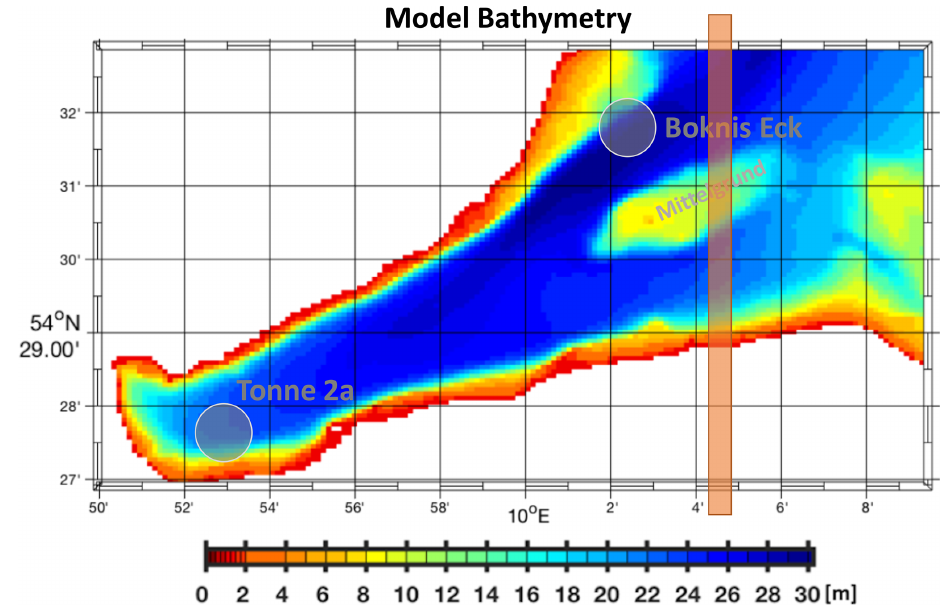
Figure 2. Model bathymetry. The horizontal and vertical resolutions are 100 and 1m, respectively. The northern and eastern boundaries are closed (rigid walls). Sea surface height, temperatures, and salinities around the closed boundaries are restored to prescribed values. Gray circles depict the locations of the observational sites at the entrance and deep inside EB. Mittelgrund is a shallow. Note that the region east of the orange rectangular area is discarded in all following plots because it is essentially determined by our boundary conditions rather than by intrinsic model